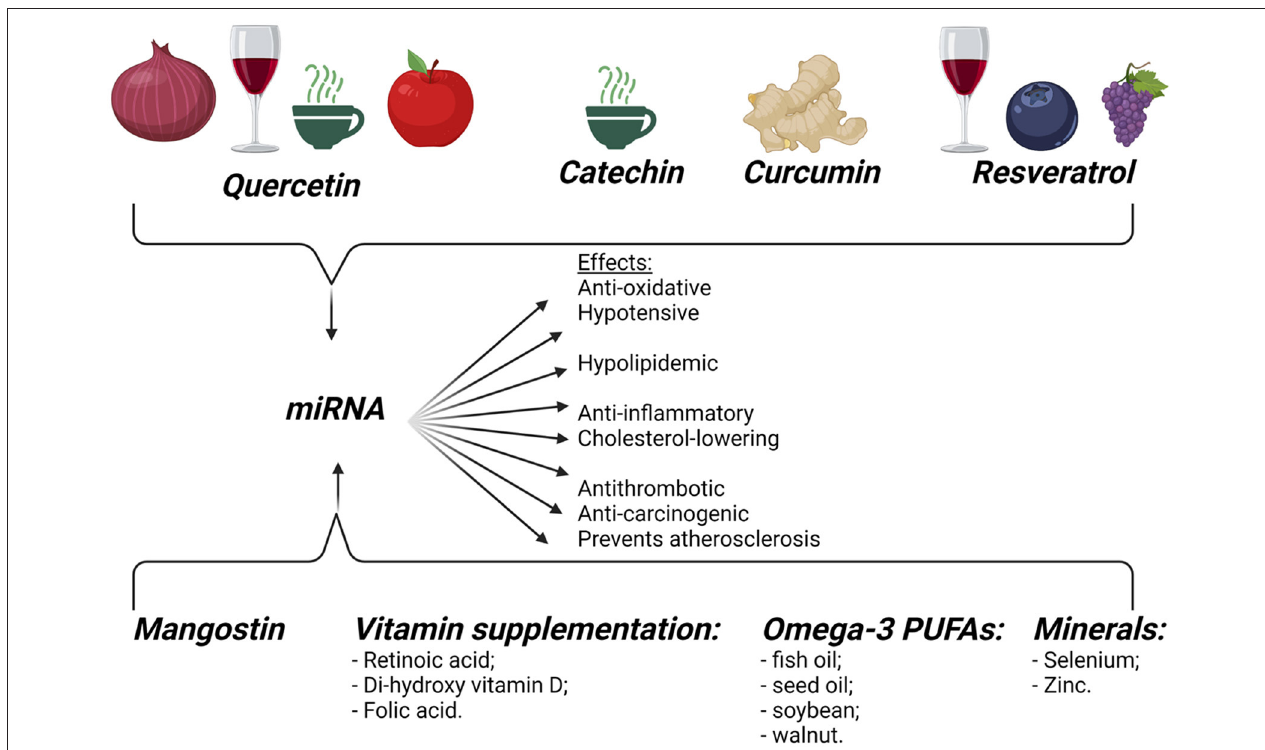
FIGURE 5 | Dietary influence on miRNAs. Dietary food components can influence gene expression, modifying the pathogenesis of different diseases, like cancer, obesity, and CVDs. Created with BioRender.com (Last accessed on 12 January 2022).